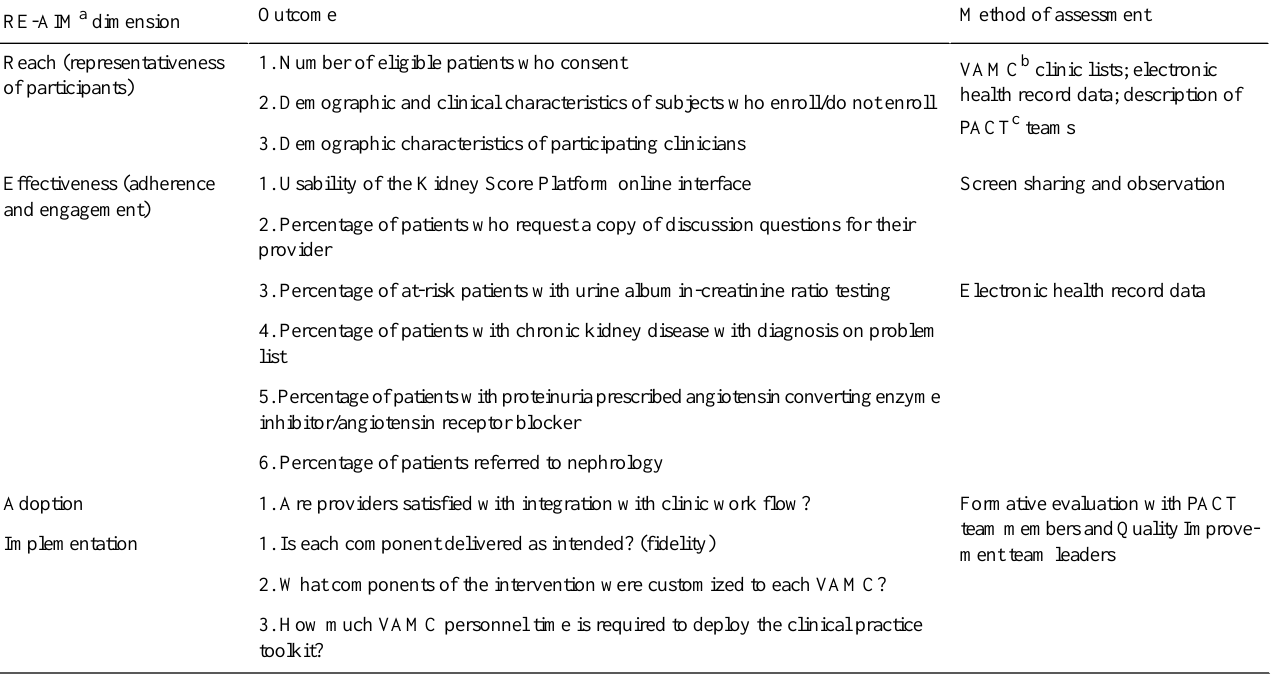
Table 3. Process outcomes for implementation analysis, based on the RE-AIM framework [32].